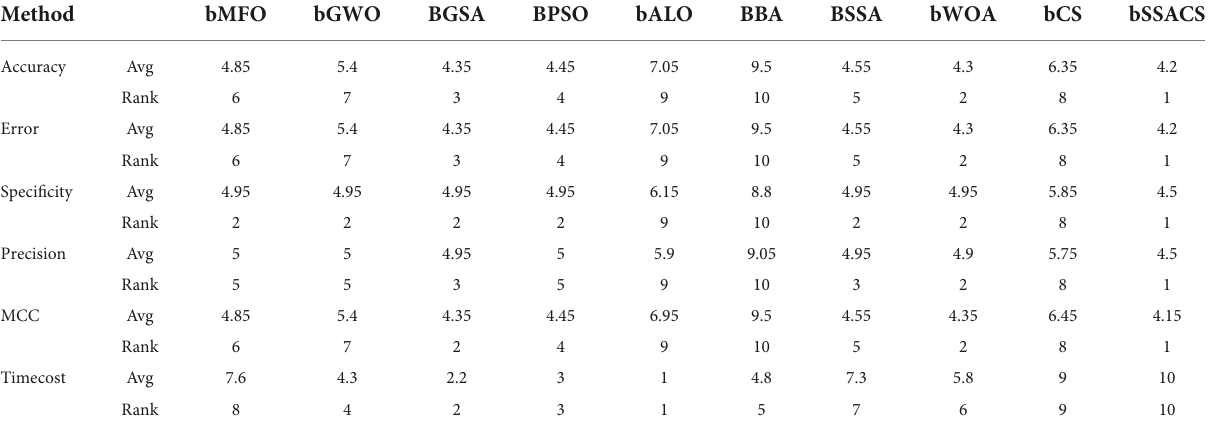
TABLE 13 Friedman test results.